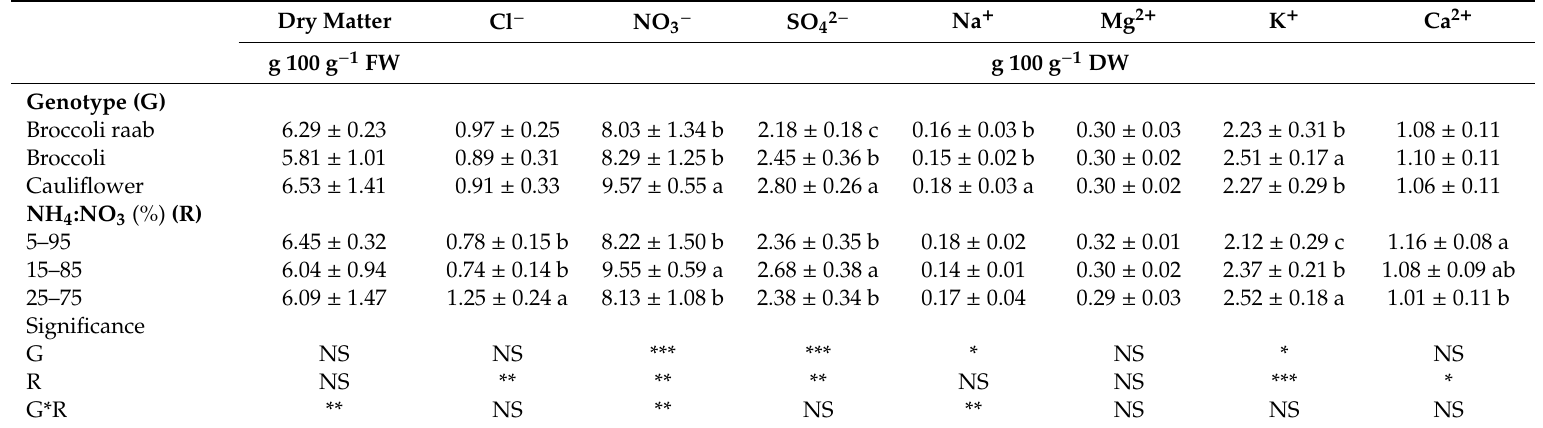
Table 6. Main e ff ects of genotypes and NH 4 :NO 3 ratio on dry matter and inorganic anion of microgreens (second